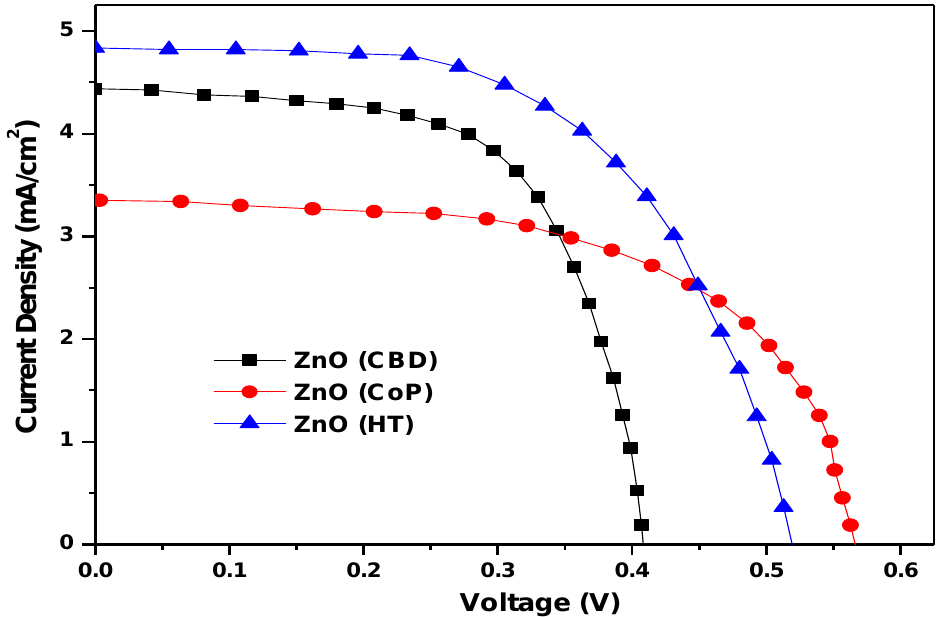
Figure 17. J-V plot of ZnO nanostructures grown through different techniques.